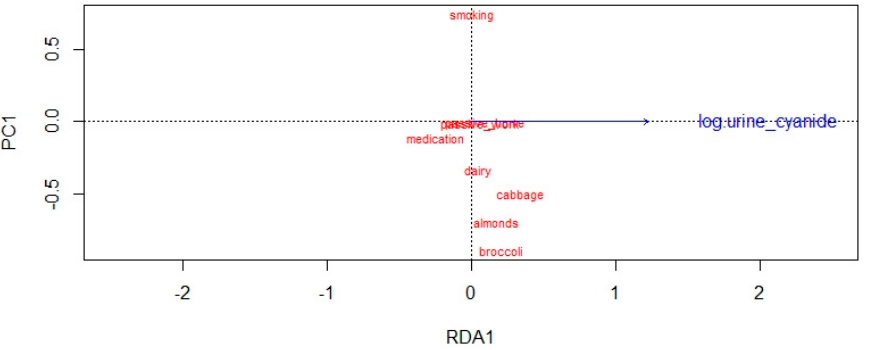
Figure 4. Redundancy analysis to discover important qualitative factors driving the cyanide concentrations in parents’ urine.